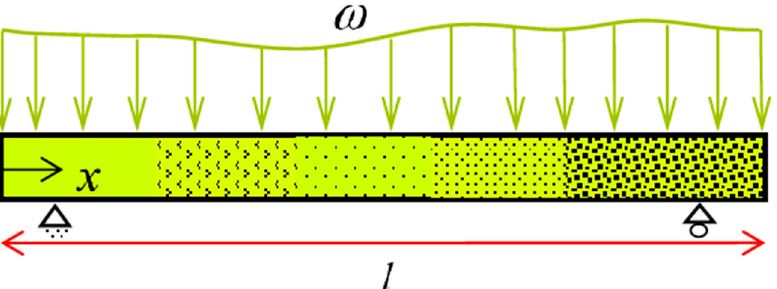
Figure 7. A prismatic SMA beam subjected to transverse loading (general bending).